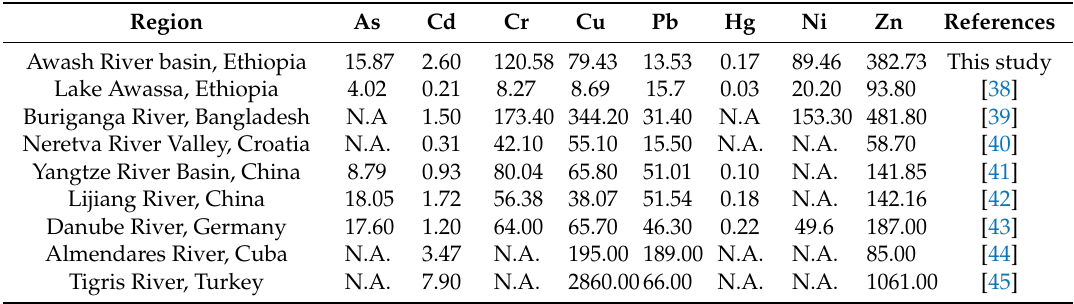
Table 2. Average heavy metal contents (mg/kg) in sediment from Awash River basin compared with aquatic environments from Ethiopia and other parts of the world. Region As